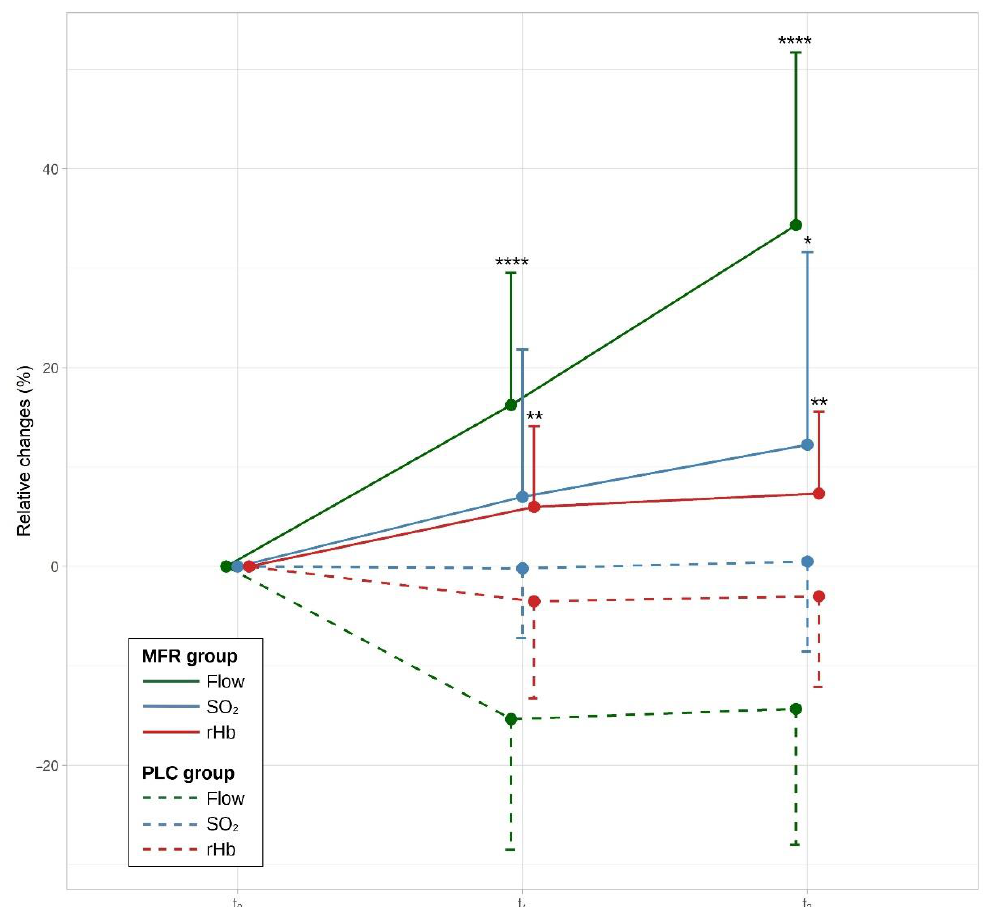
Values show relative changes in percent compared to baseline measurement. SO 2 , oxygen satura-